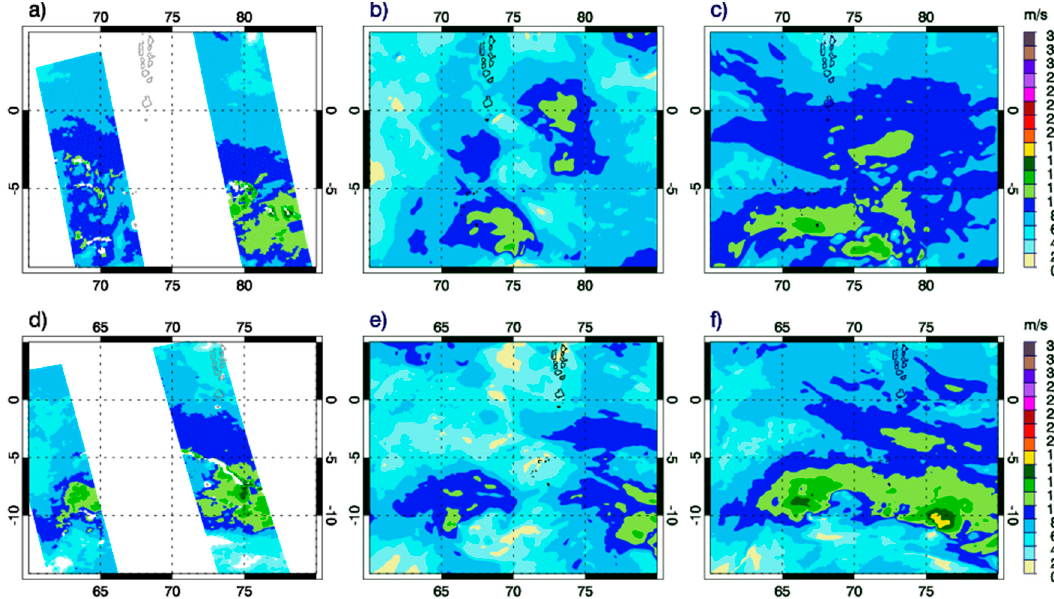
Figure 11. Surface wind speed near the WWB event from ( a ) ASCAT observation around 1448 UTC, and prediction from ( b ) CTRL, and ( c ) DA_com at 1500 UTC on 7 January 2018; and ( d ) ASCAT around 1524 UTC, and surface wind prediction from ( e ) CTRL, and ( f ) DA_com at 1600 UTC on 8 January 2018.